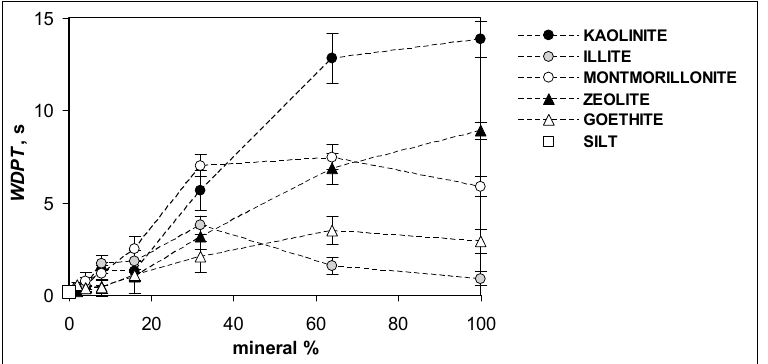
Figure 7. Dependence of water drop penetration time on the added minerals’ percentage. Error bars are standard deviations.